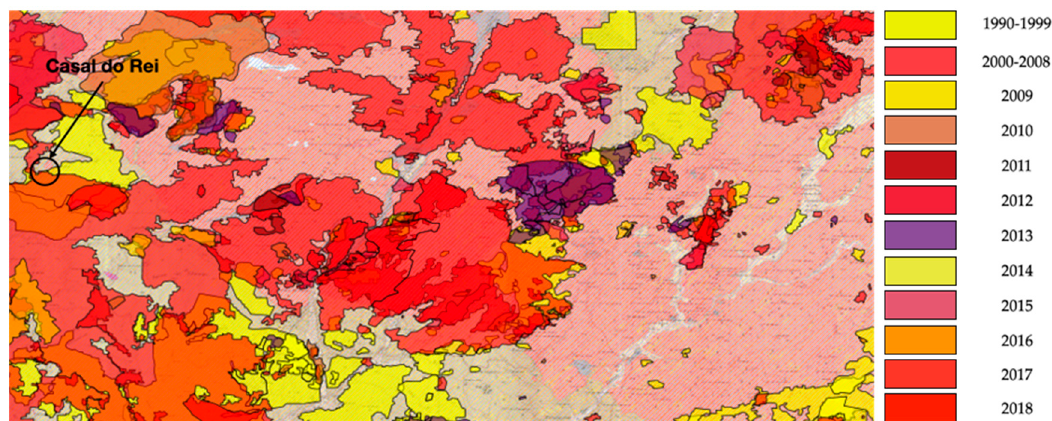
Figure 6. Overlapping of the burnt areas over the period between 1990 and 2018.